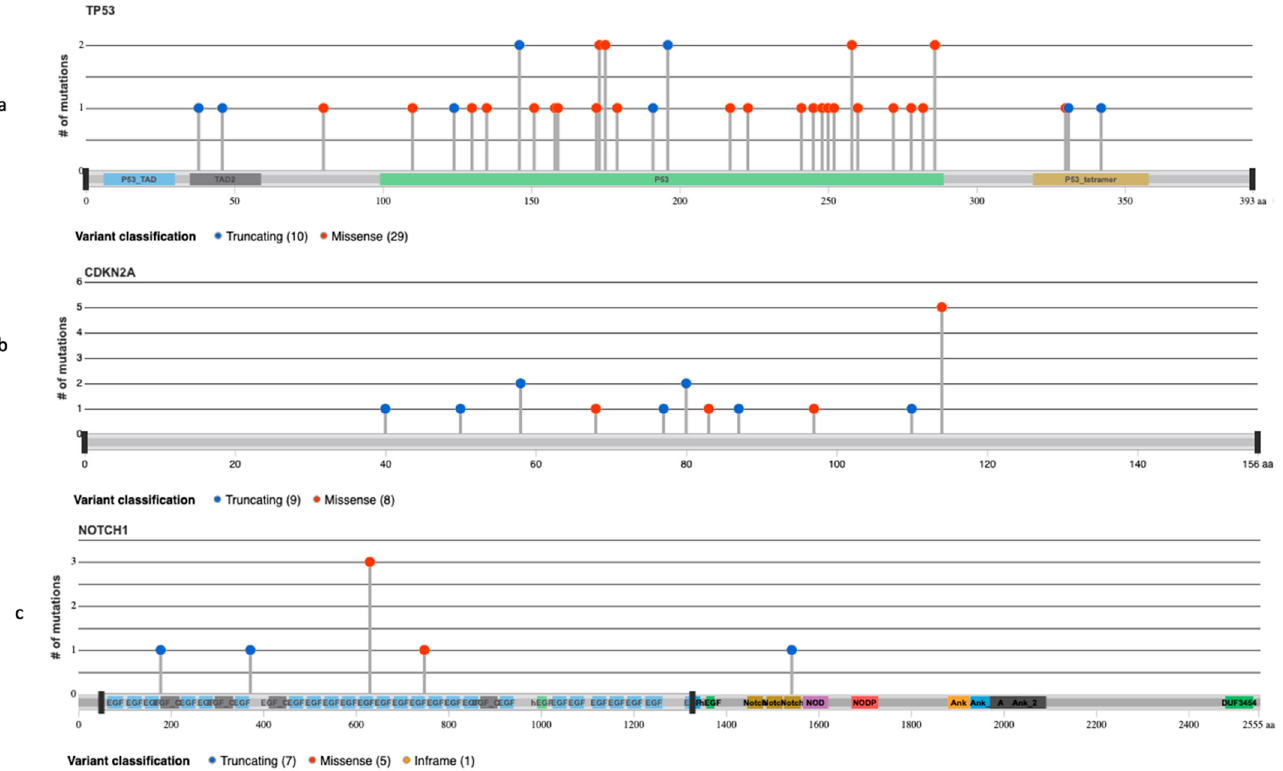
Figure 4. Lollipop plots highlighting genomic alterations of known and likely mutations in selected genes: ( a ) TP53 (tumor protein 53), ( b ) CDKN2A (cyclin-dependent kinase inhibitor 2A), and ( c ) N OTCH1 (NOTCH receptor 1) in AFX and PDS. Circles are colored with respect to the corresponding mutation types. Color codes are as follows: blue circles are indicating truncating mutations; red circles missense mutations and orange circles are indicating in-frame mutations. The height of the line represents the number of mutations at the specified position. The grey bar represents the entire protein with the different amino acid positions (aa). The coloured boxes are specific functional domains.